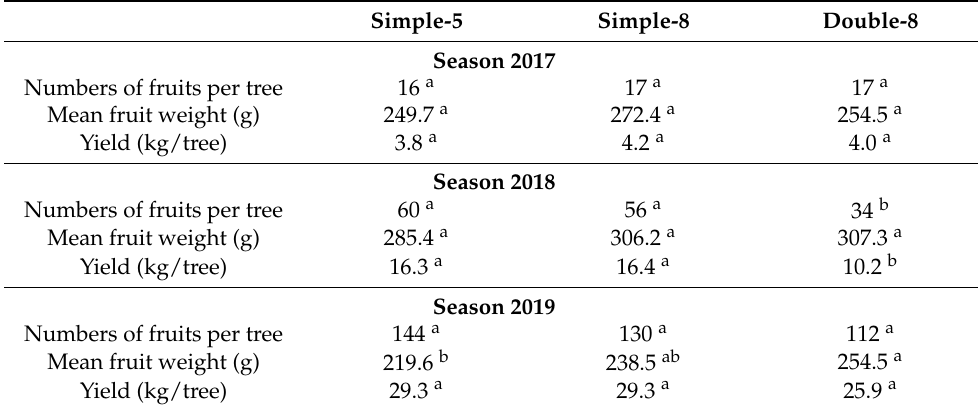
Table 7. Effects of the different irrigation regimes on persimmon yield and its components. Different letters indicate significant differences between